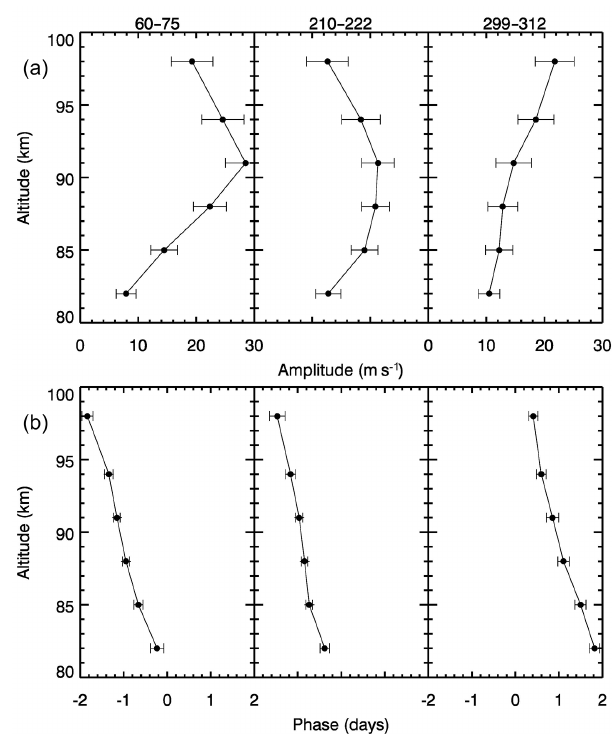
Figure 5. Vertical amplitude (a) and phase profiles (b) of the 3–4- day common oscillations in the zonal wind and airglow. Numbers on the top panels indicate the days of the